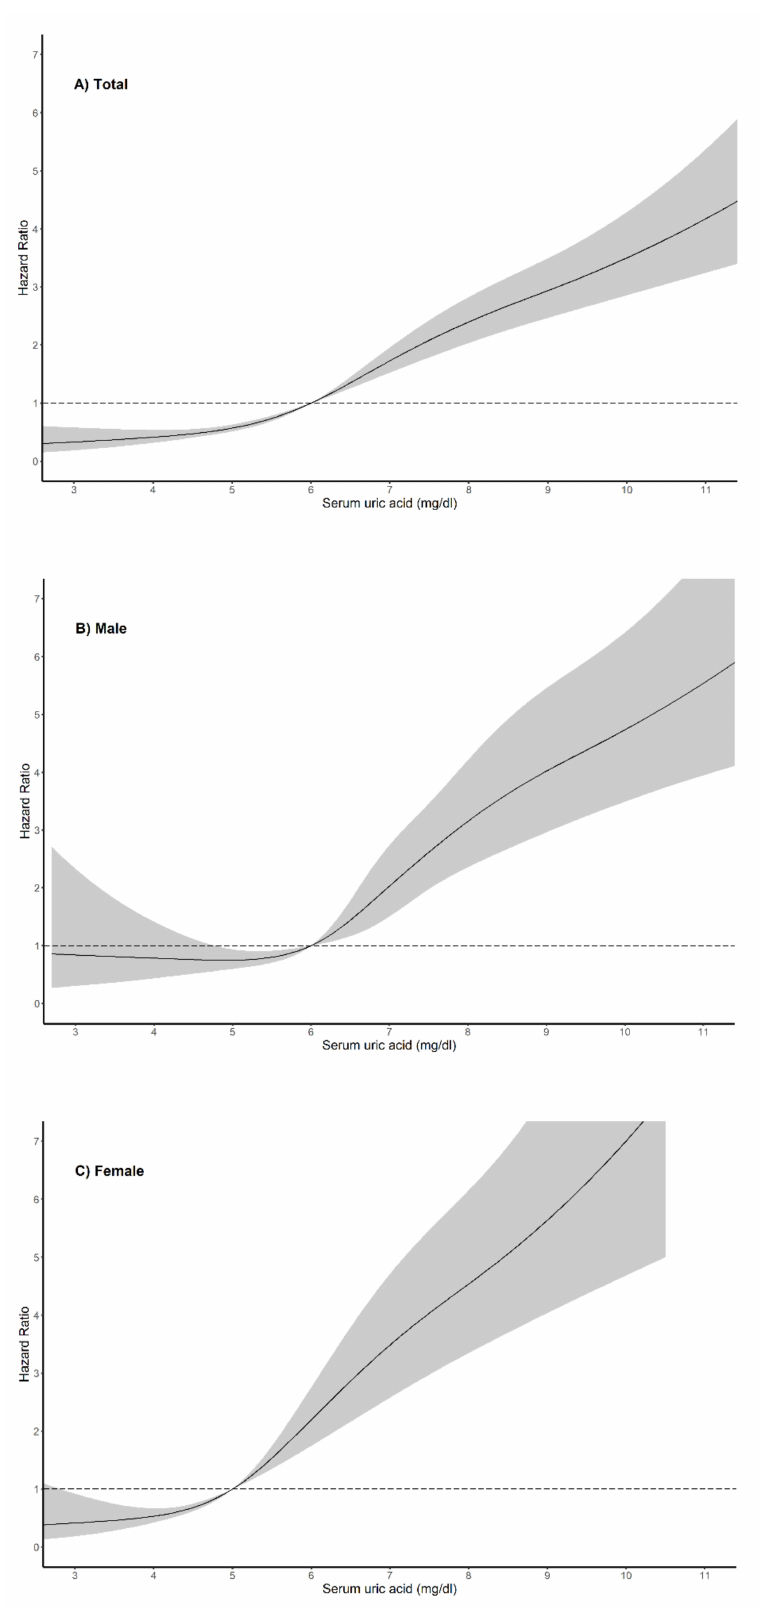
Figure 4. Restricted cubic spline curve of hazard ratio of serum uric for major adverse renal outcome by